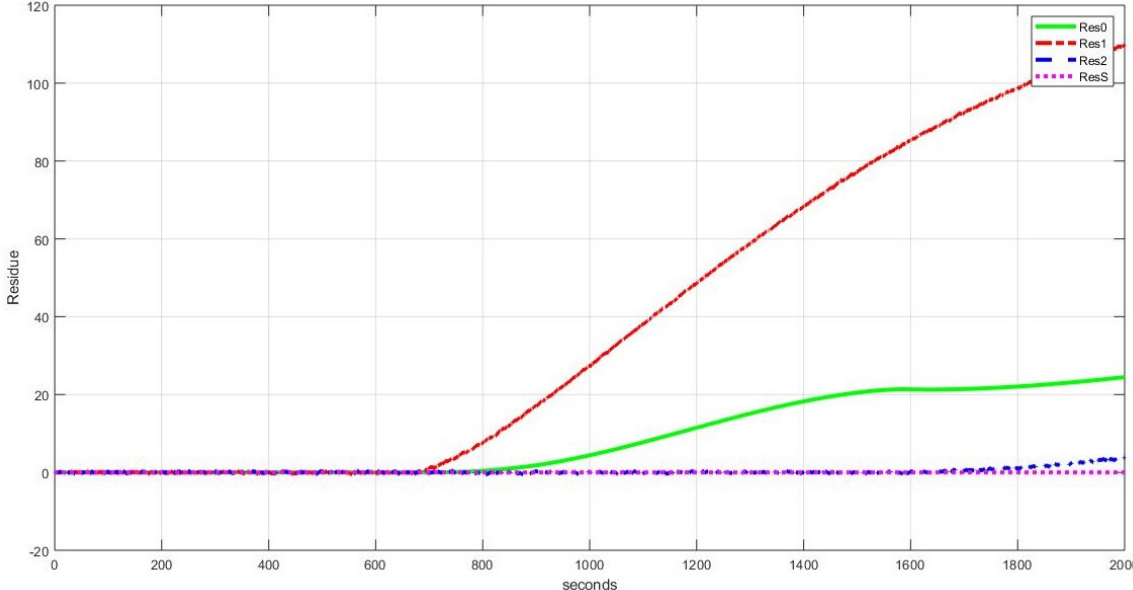
Figure 11. Pond residues for the leakage fault of sluice gate w 1